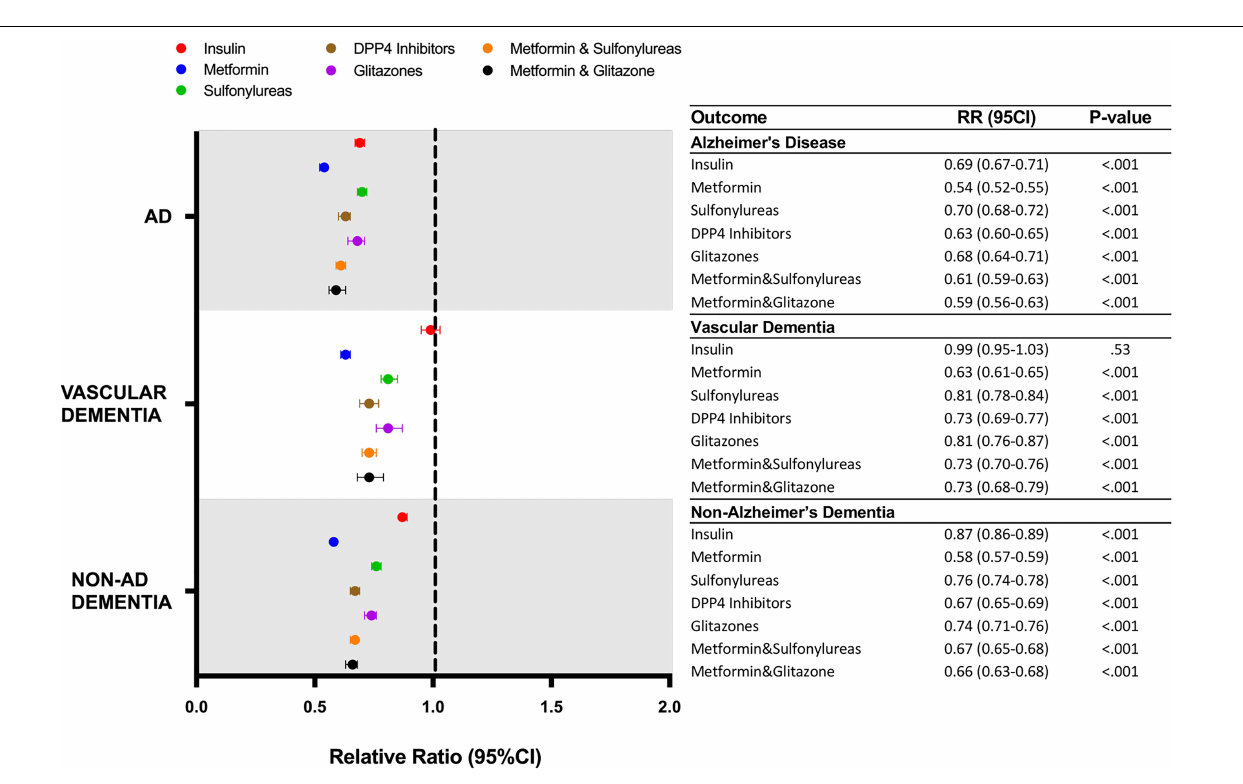
(42.84%) were exposed to 3 drugs, and 22,268 (3.49%) were exposed to 4.